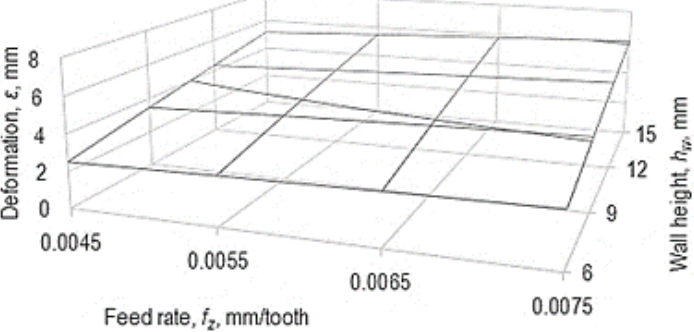
Figure 8. Influence exerted by the feed rate f z and the wall height h w on the value of deformation ε ( v = 100 m/min, t t = 1.2 mm, t w = 0.2 mm, w w = 10 mm).